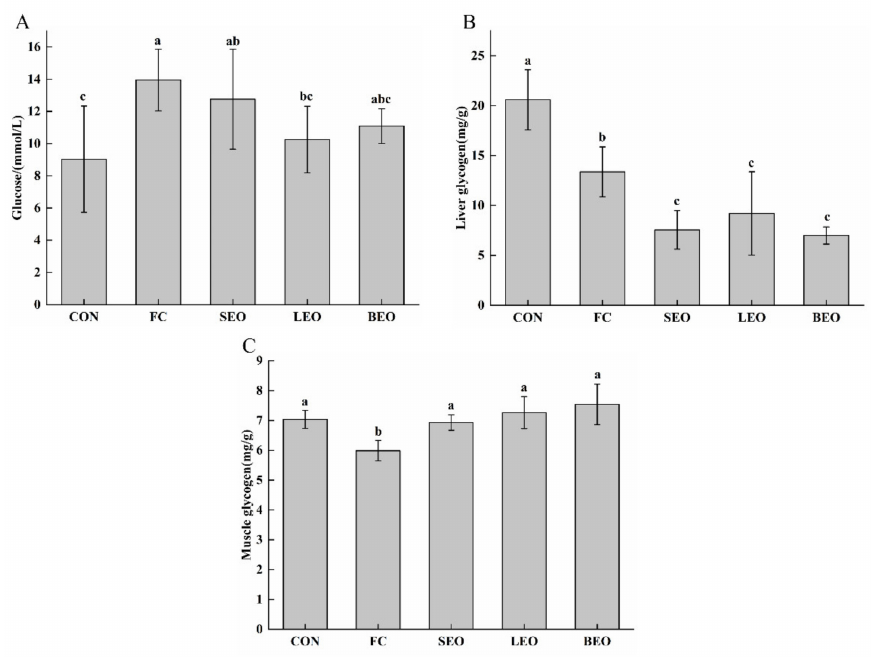
Figure 3. Effects of the inhalation of the CEOs on energy supply in exercise-induced fatigue rats. ( A ) Glucose in serum, ( B ) LG in liver, ( C ) MG in gastrocnemius. Data are the means ± SD. Different lowercase letters indicate significant differences, p < 0.05.